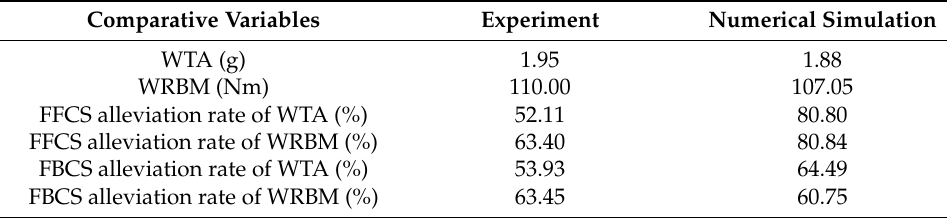
Figure 15. Comparison between simulation and test of gust response (without control). Table 3. Comparison between wind tunnel test and numerical simulation.